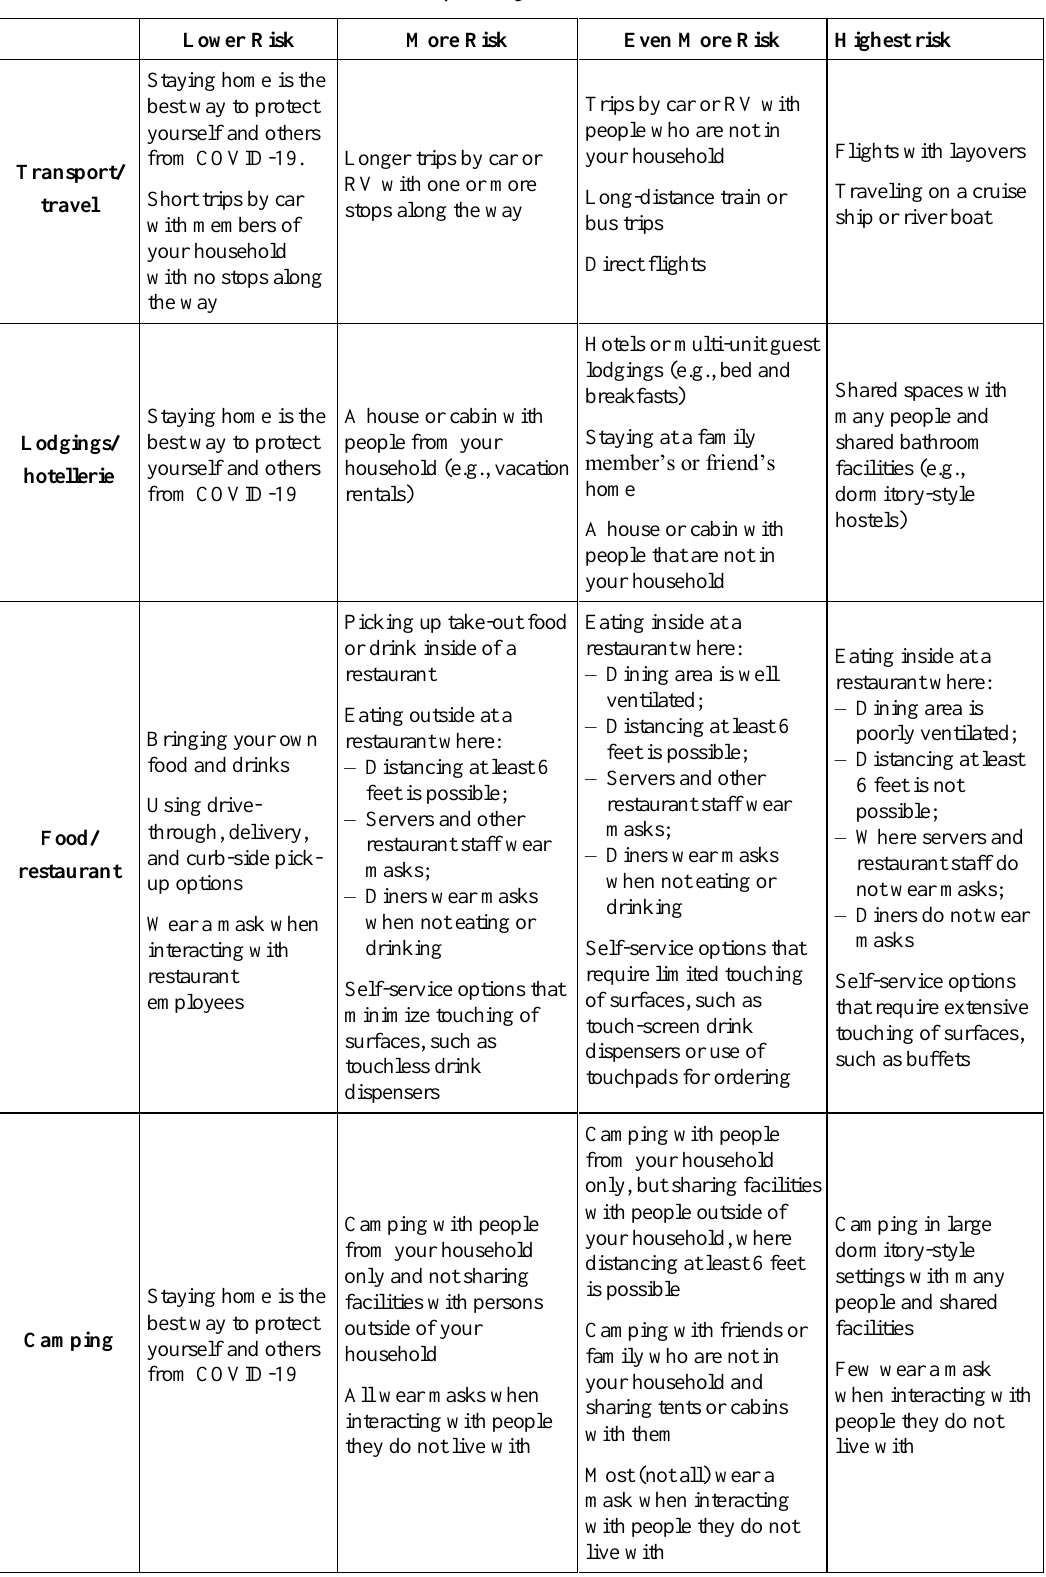
Table 1: Risk and Tourism and Hospitality Activities 2,3 Lower Risk More Risk Even More Risk Highest risk